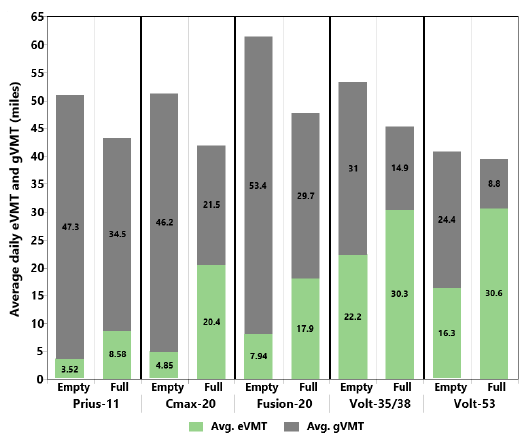
Figure 9. Impact of Travel Day Starting SOC on Average daily eVMT and gVMT.